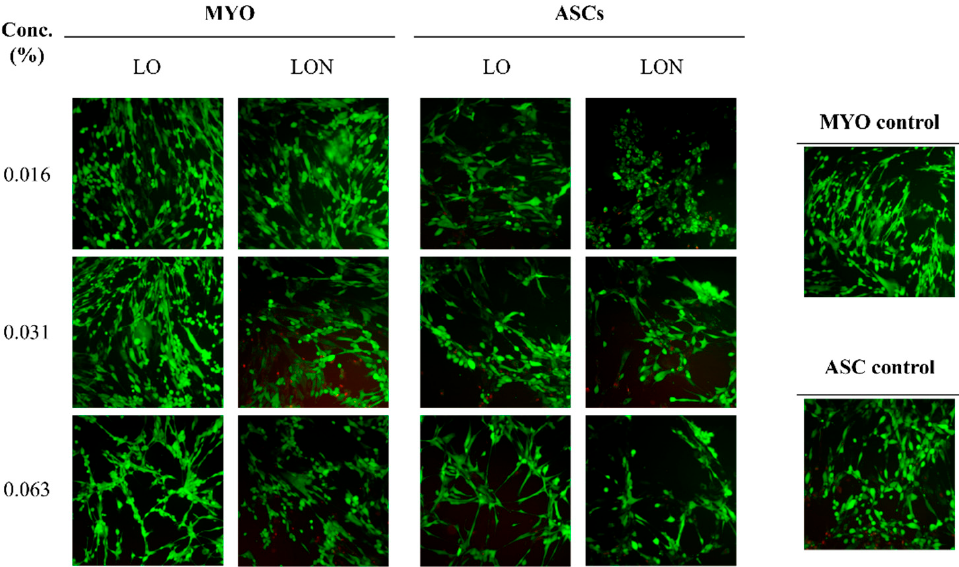
Figure 3. Cytotoxicity of LO and LON in different concentrations for myometrial cells (MYO) and ASCs using live/dead assays. Live cells are shown in green and dead cells in red ( n = 3).